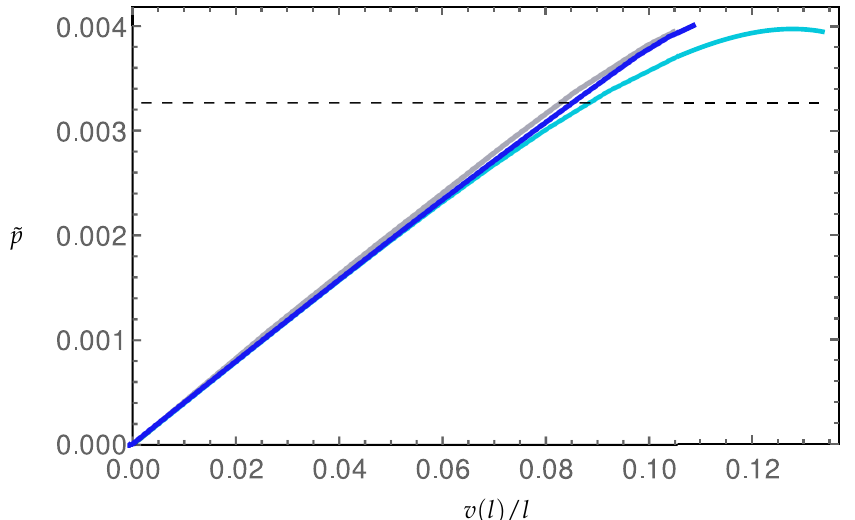
Figure 5. Distributed force: evolution of the tip displacements while increasing the amplitude of the load ( ˜ p : = p v l ). Black dashed line: load condition of Figure 4; blue line: perturbation π R ( G e he + G i hi ) solution; light blue line: finite difference method; gray line: